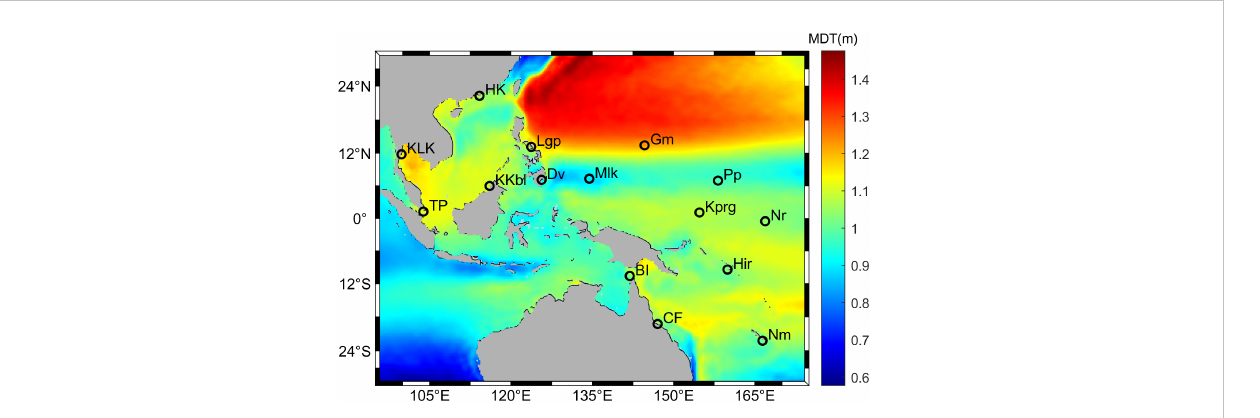
FIGURE 1 Mean dynamic topography over the study region based on the CNES-CLS18 dataset (Mulet et al., 2021) and the locations of 15 selected tide gauges: Pohnpei (Pp), Nauru (Nr), Malakal (Mlk), Honiara(Hir), Noumea (Nm), Kapingamarangi (Kprg), Guam (Gm), KoLaK (KLK), HongKong (HK), Booby Island (BI), Cape Ferguson (CF), Legaspi (Lgp), Davao (Dv), Kota Kinabalu (KKbl), Tanjong Pagar